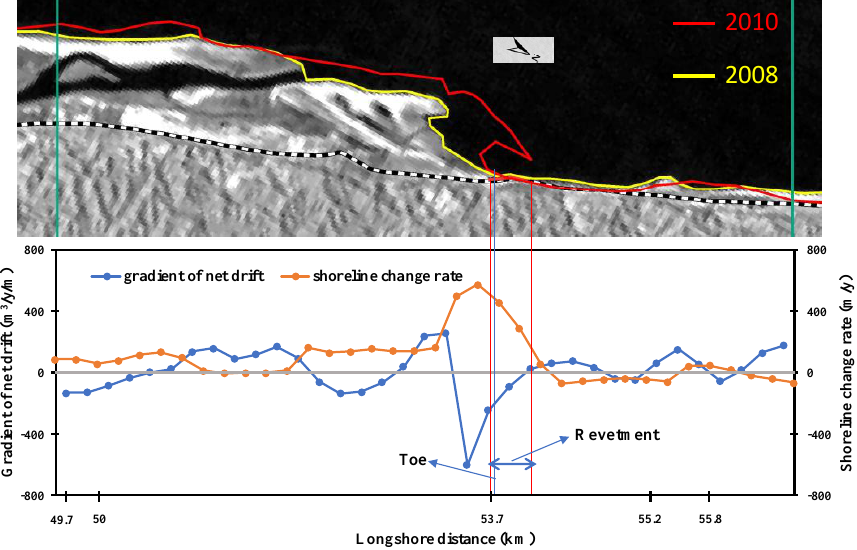
Figure 27. Relation between the gradient of the net drift and shoreline change rates during 2008–2010. A positive (negative) gradient induces erosion (accretion).